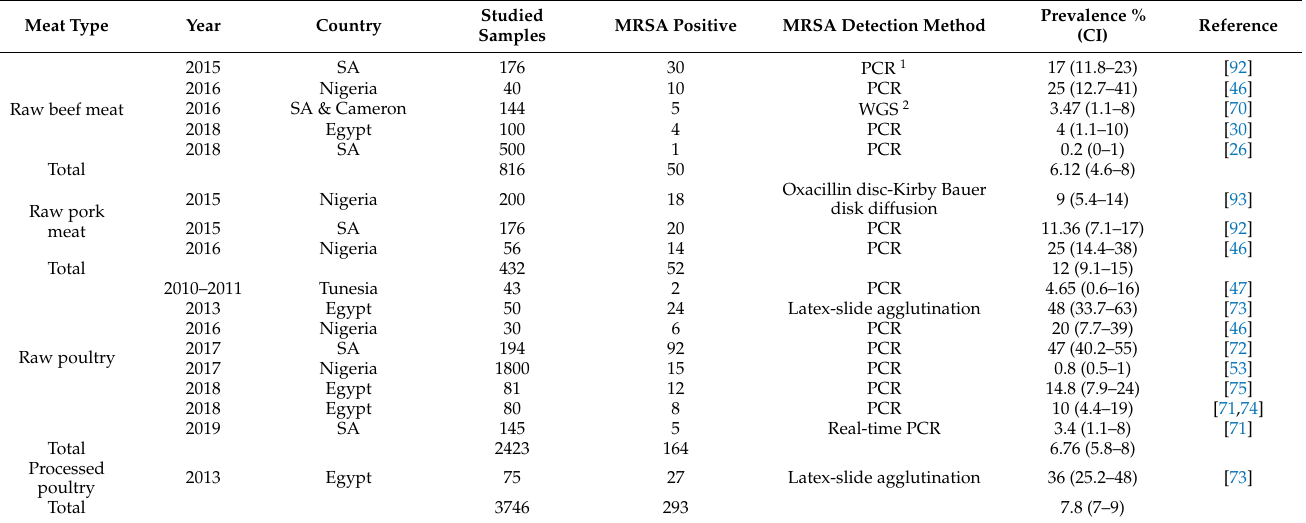
Table 8. Prevalence of methicillin-resistant S. aureus (MRSA) in different types of meat from Africa.